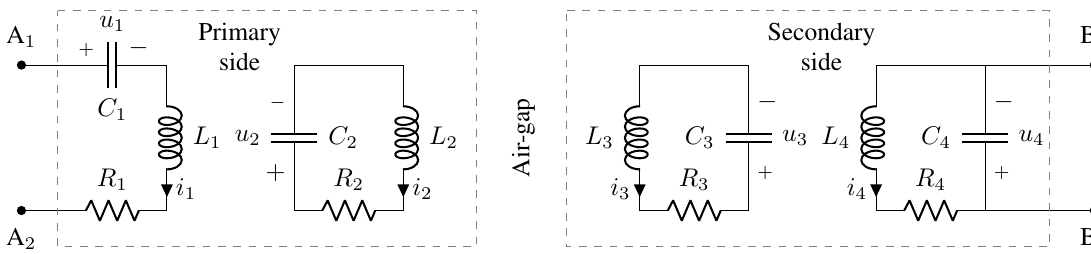
Fig. 2. Circuit diagram for the magnetically coupled resonators with four coils and capacitors.